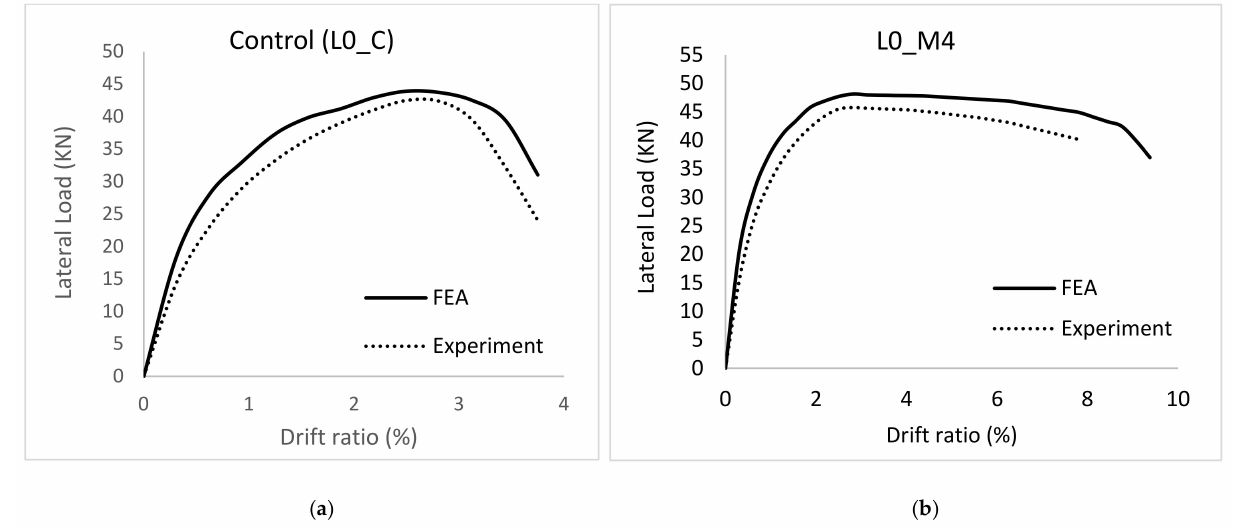
Figure 6. Load versus drift ratio envelopes: ( a ) L0_C, ( b ) L_M4. Table 2. Strains in Longitudinal Bars.